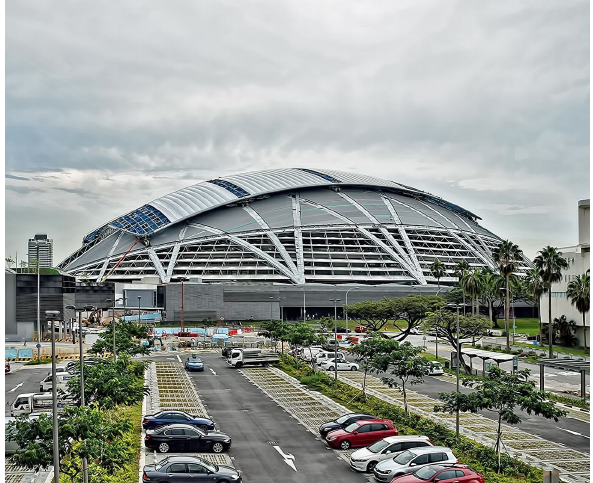
Figure 2: National Stadium in Singapore (cf.